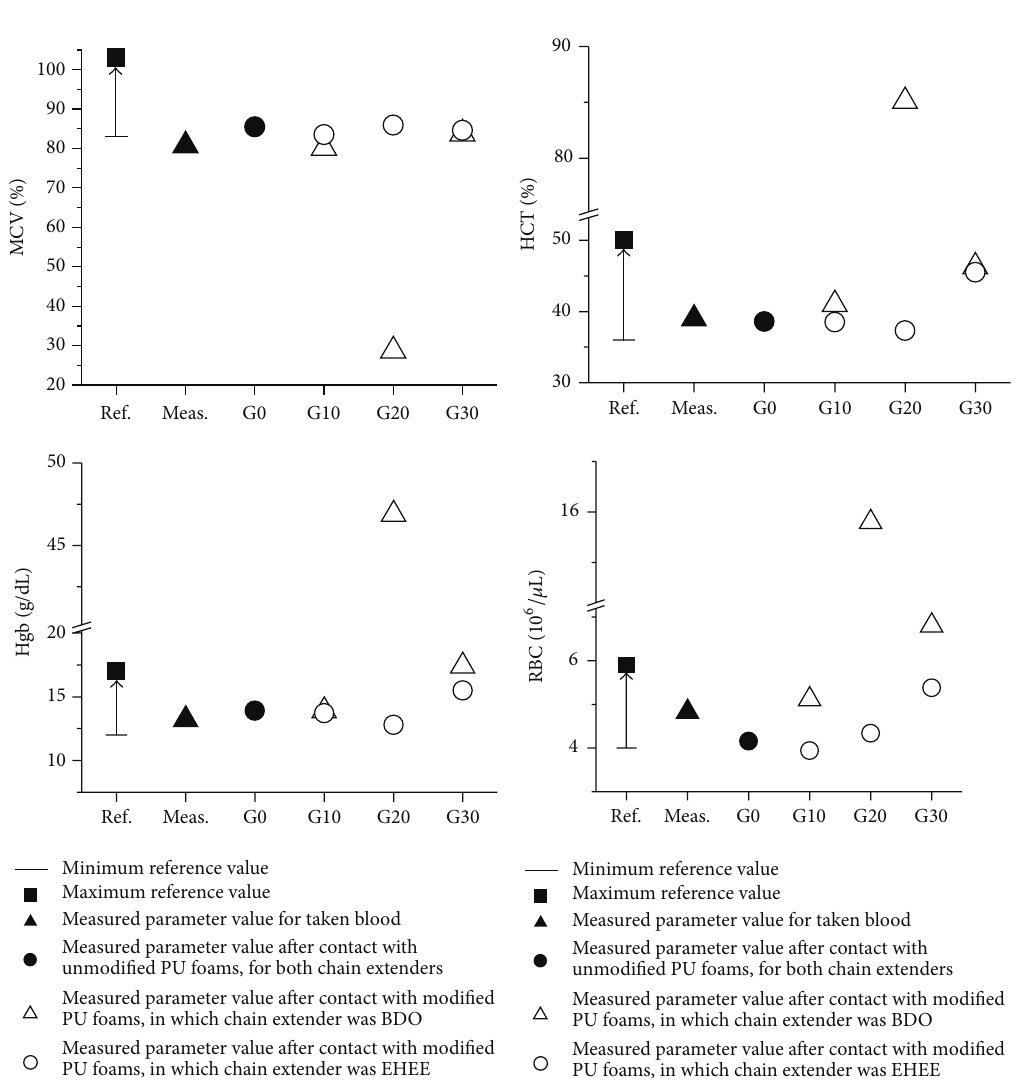
Figure 8: Blood parameters of all investigated samples, with values above reference range (some deviation from reference range was noticed, with a concentration on G20 PU samples, in which chain extender was BDO).